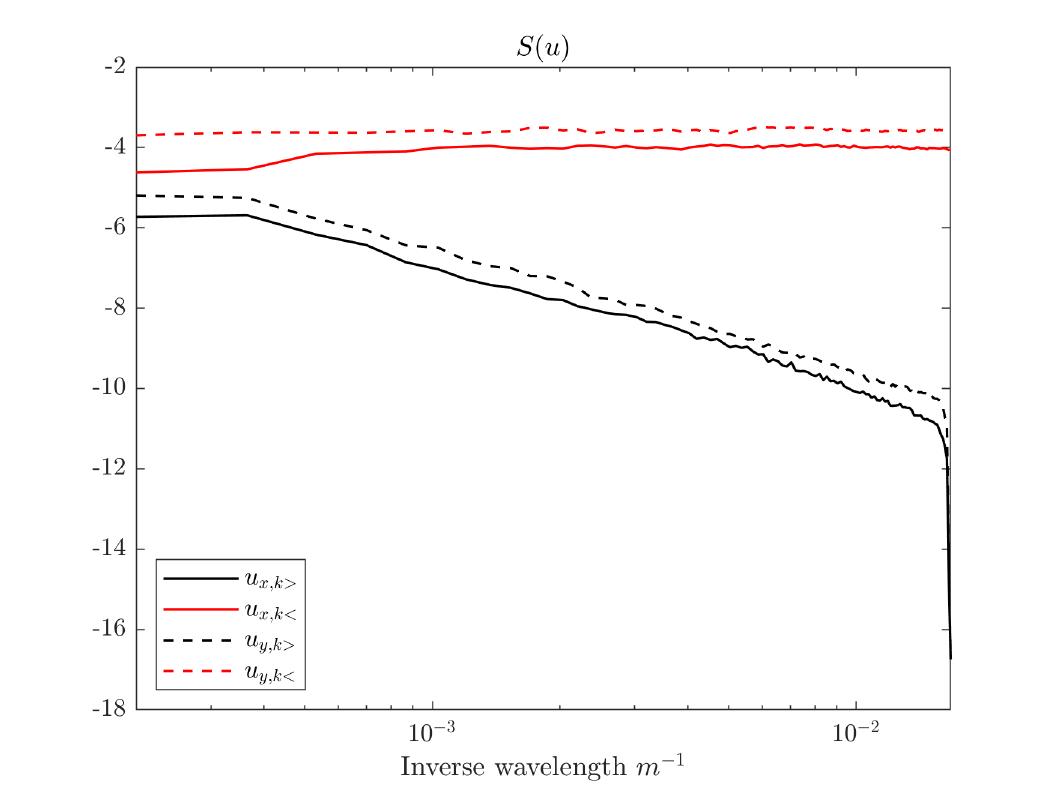
Figure 11. The entropy distribution.